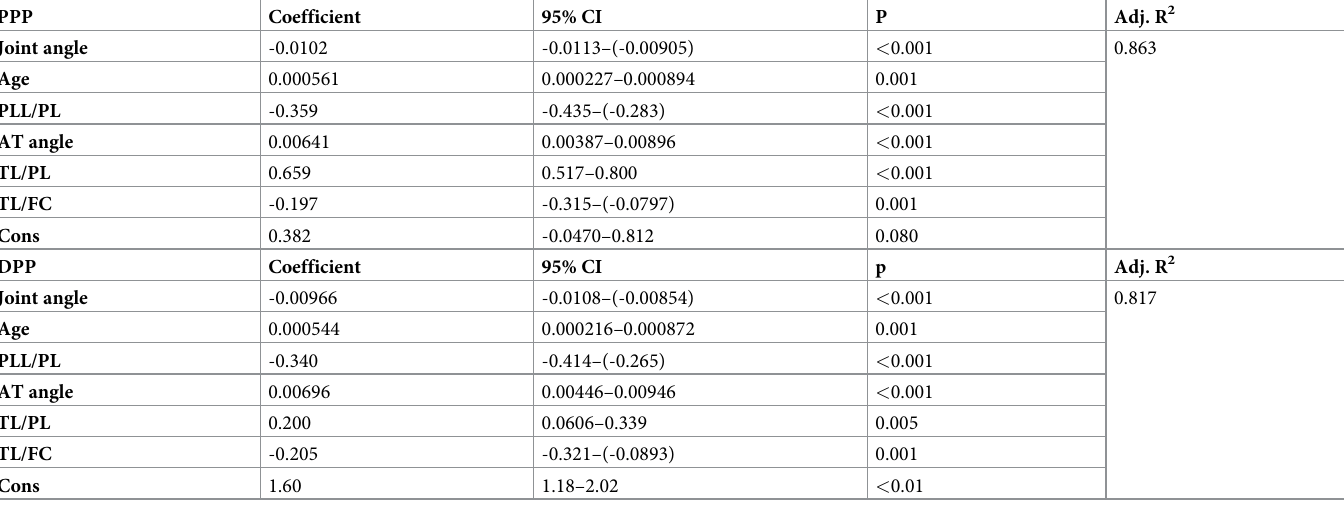
Table 4. Final models of the multivariable regression analyses for PPP or DPP and morphological factors.